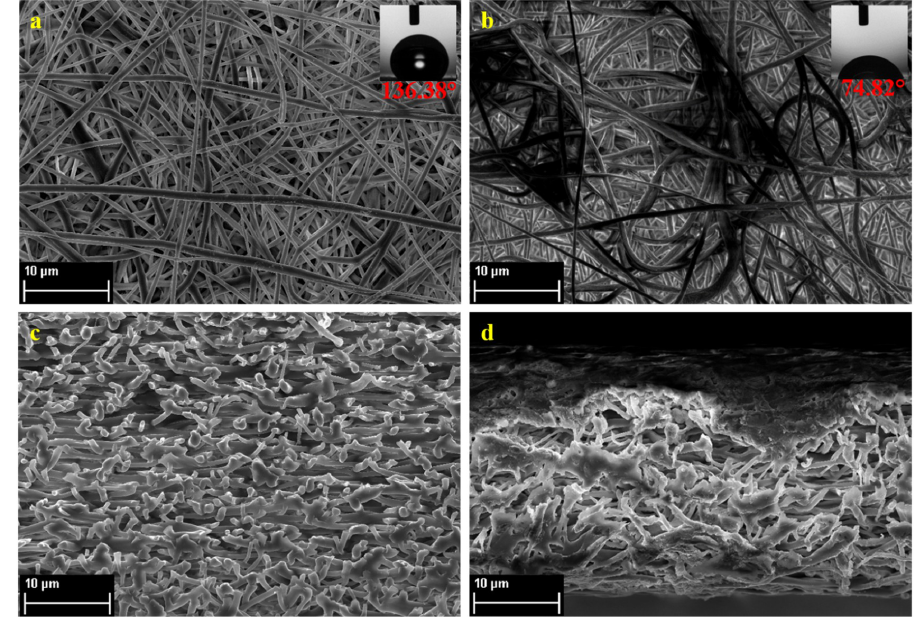
Figure 2. FESEM images of the ( a,b ) top surface of and ( c,d ) cross section of pure PVDF and PVDF-PAA nanofiber mats, respectively.